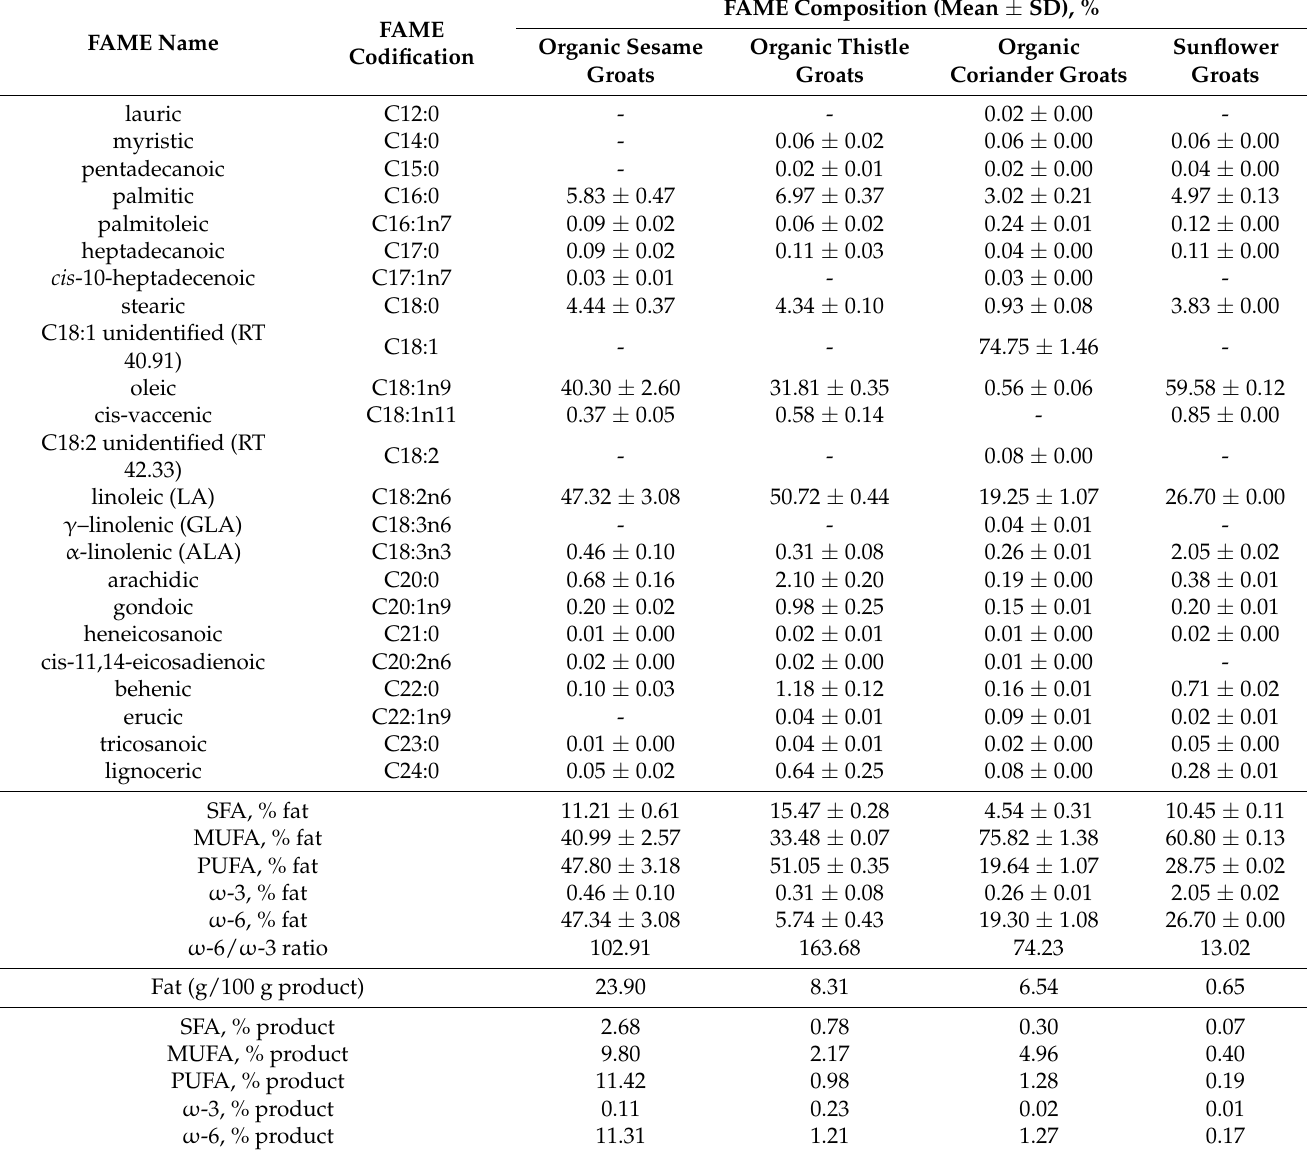
Table 4. Fatty acid methyl esters content of groat